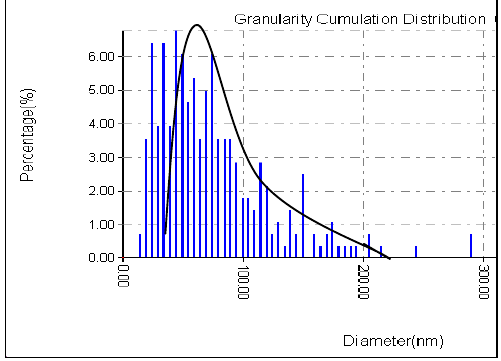
Fig. 5 a: AFM image of CdTe NPs. Fig. 5 b: Histogram of their size distribution in